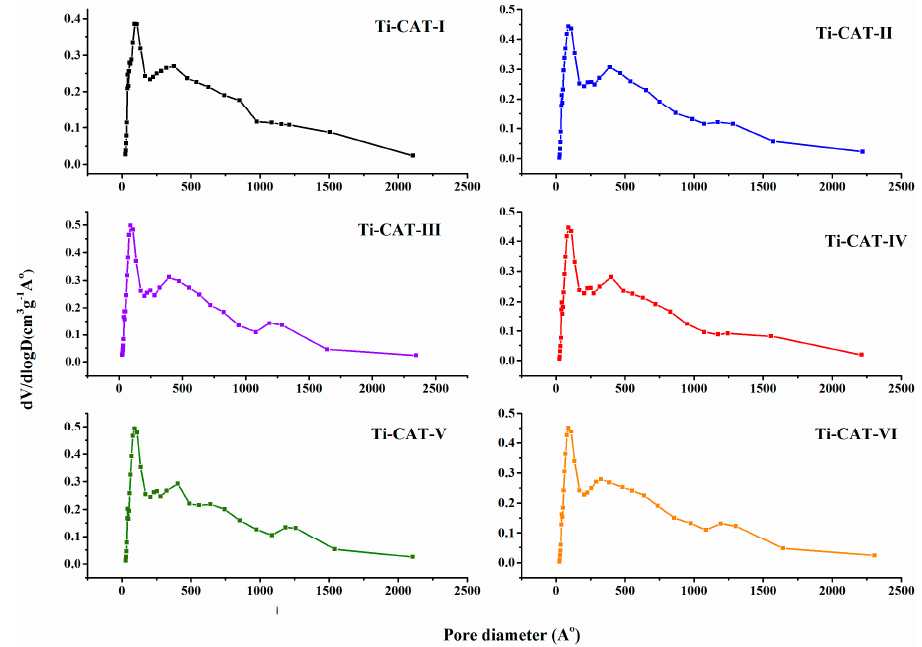
Figure 2. N 2 adsorption-desorption isotherms and BJH desorption pore size distribution curves for Ti-CAT samples .